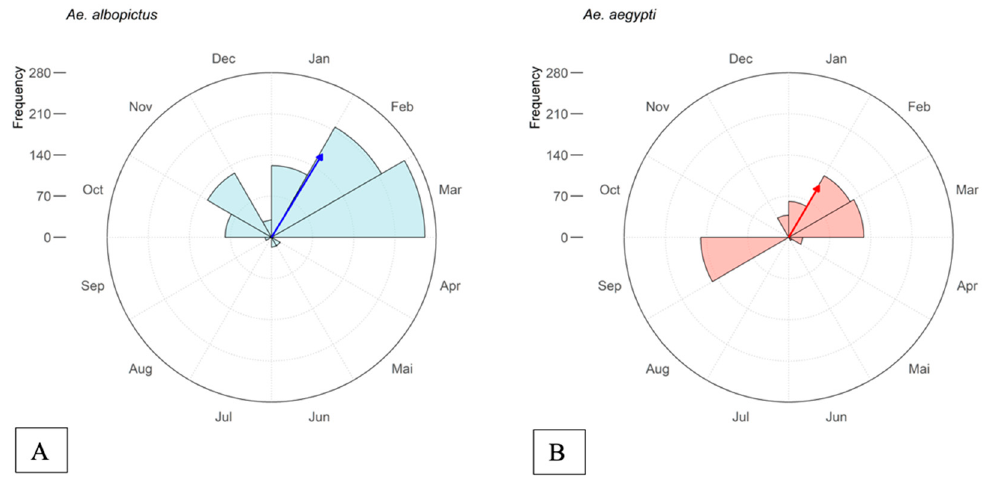
Figure 5. ( A ) Distribution of Ae. albopictus identified from eggs collected in ovitraps by month from September/2017 to September/2018 in Morretes, Paraná; ( B ) Distribution of Ae. aegypti identified from eggs collected in ovitraps by month from September/2017 to September/2018 in Morretes, Paraná. The vector direction concentration points out the mean peak oviposition date for each species. The longer the vector, the more concentrated the oviposition around the mean peak date.